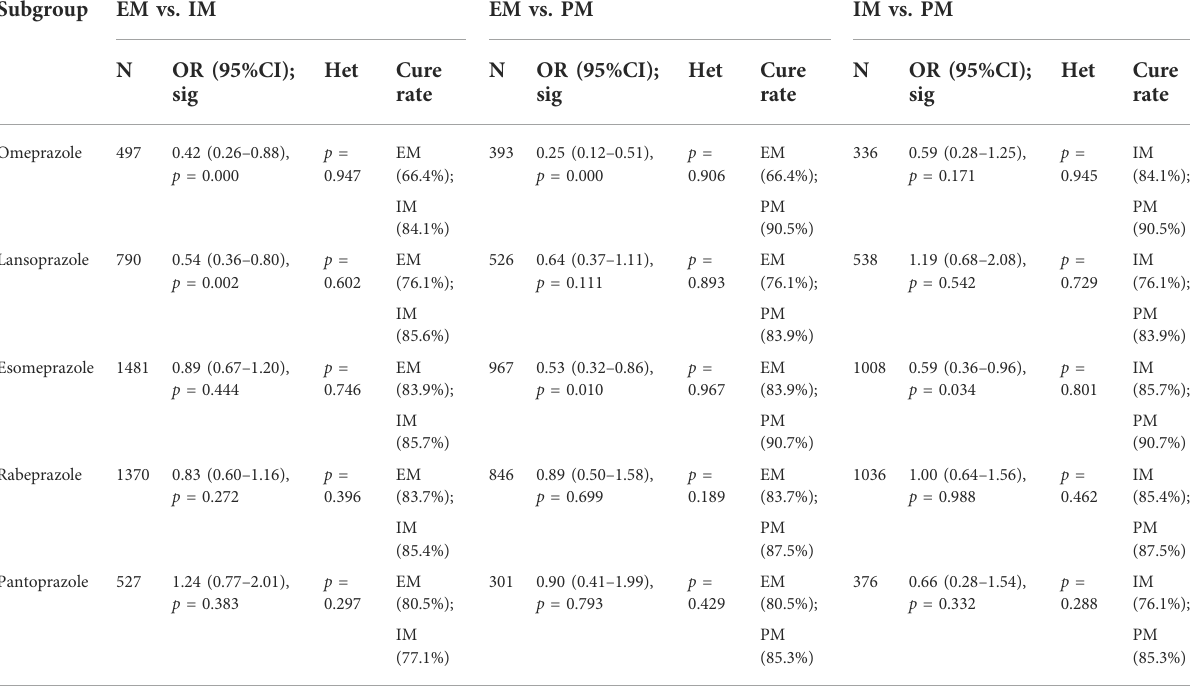
TABLE 4 Ef fi cacy of CYP2C19 polymorphisms on the cure rates of H. pylori in the treatment regimens containing different PPIs. Subgroup EM vs. IM EM vs. PM IM vs.